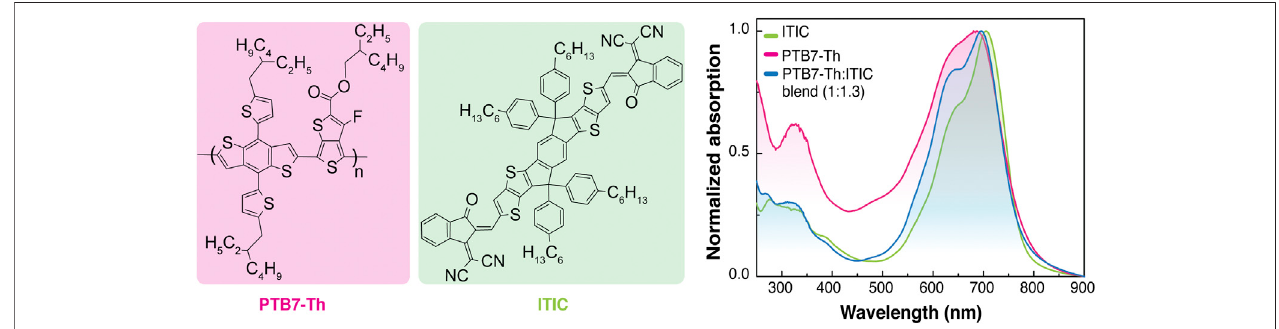
FIGURE 1 | Chemical structure and absorption spectra of the components in the BHJ layer of the studied OPV cells (PTB7-Th and ITIC) as spin-cast fi